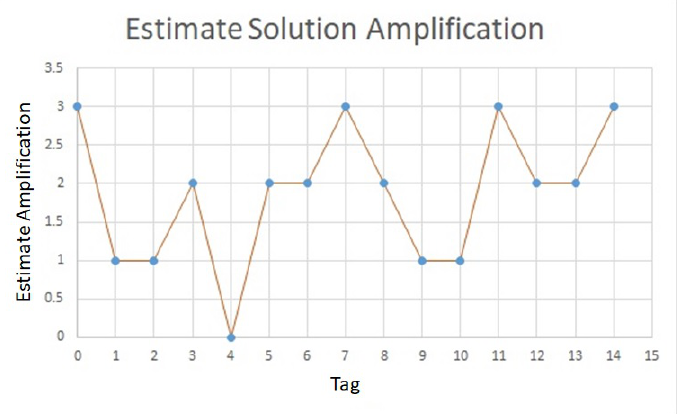
Figure 10. Estimate of the solution probability trend as a numerical estimate of expected results of a sample